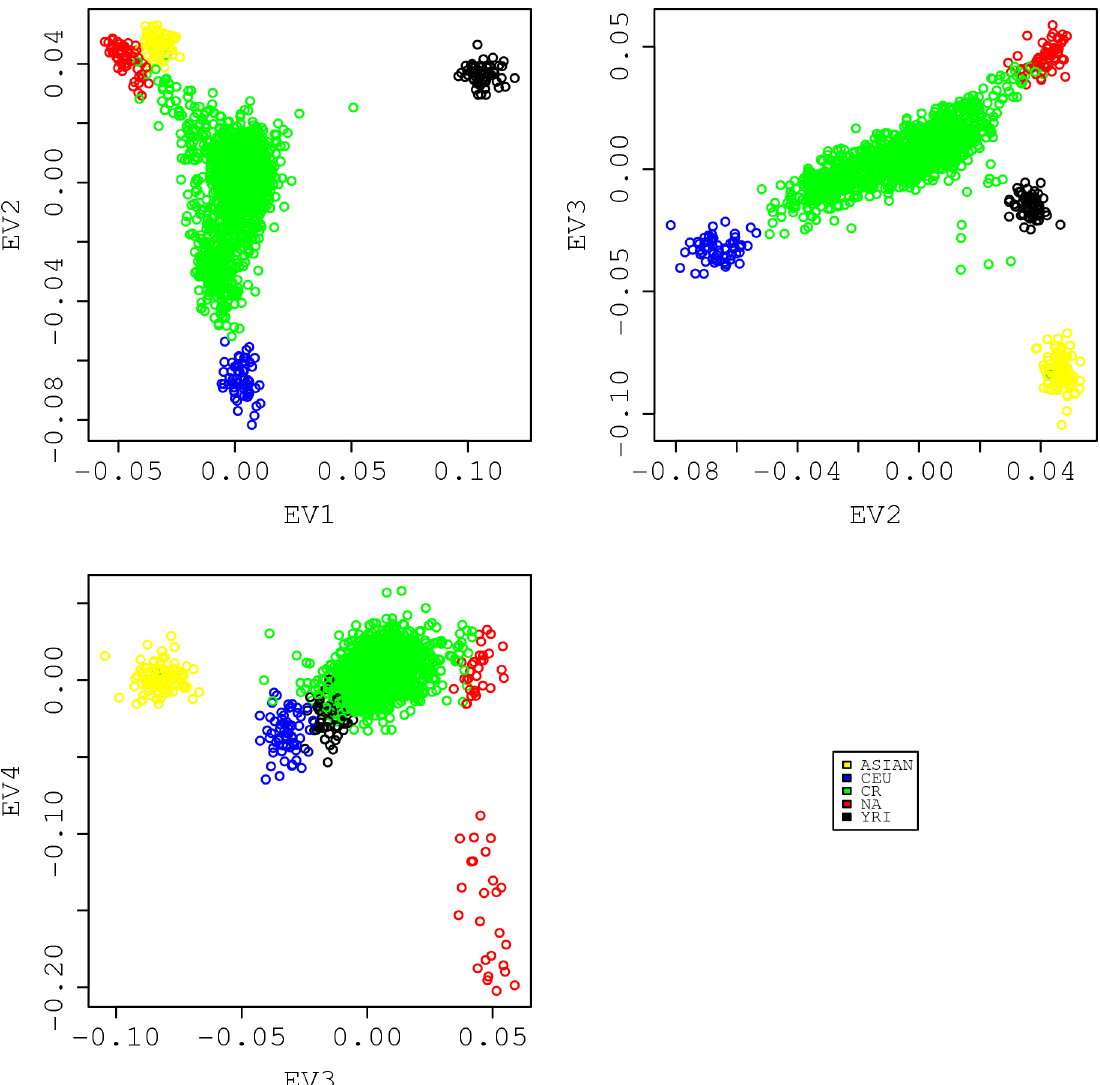
Figure 3. Principal component analysis result. The analysis was conducted on a combined set of samples (the same as the one used for STRUCTURE analysis shown in Figure 2) with 2,663 structure inference SNPs. The top 4 principal components explain a total of 78.5% of the variance in the data, and the corresponding eigenvectors are shown in pairwise scatter plots in this figure.